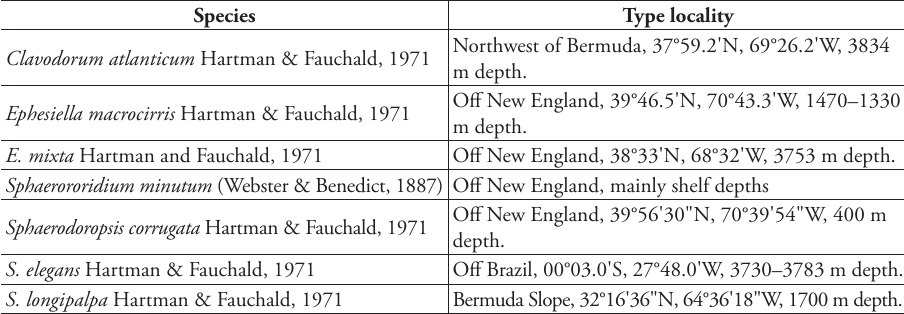
Table 1. Species recorded in northwestern Atlantic shelf, slope and abyssal depths. Species Type